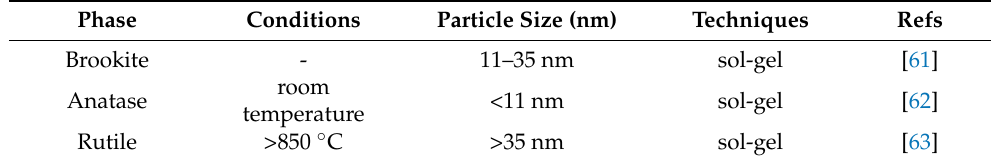
Table 4. Different phases of TiO 2